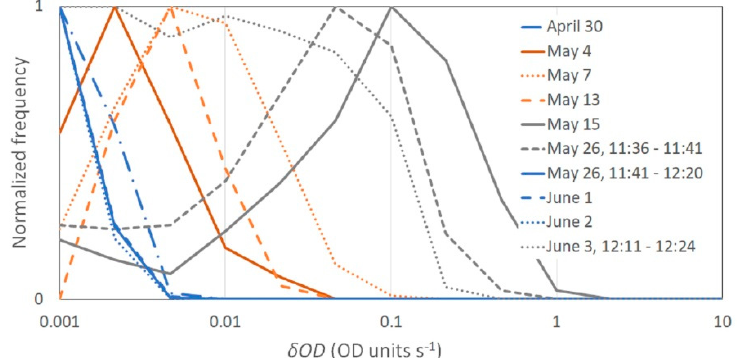
Figure 7. Frequency normalized histograms of retrieved δ OD (at 500 nm) for some periods with clear sky conditions along the solar ray path (in blue), high thin cloudiness (in orange), and broken cloudiness (in grey). Note that the binning in the δ OD is logarithmic, and therefore the area under each curve is not unity. Scale in the horizontal axis has units of optical depth per second.